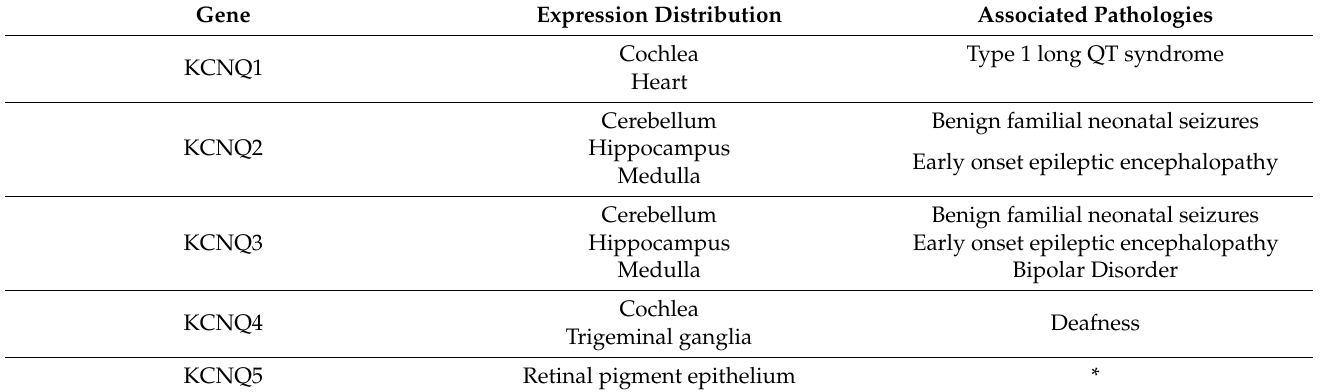
Table 1. Expression distribution and associated pathologies with channel